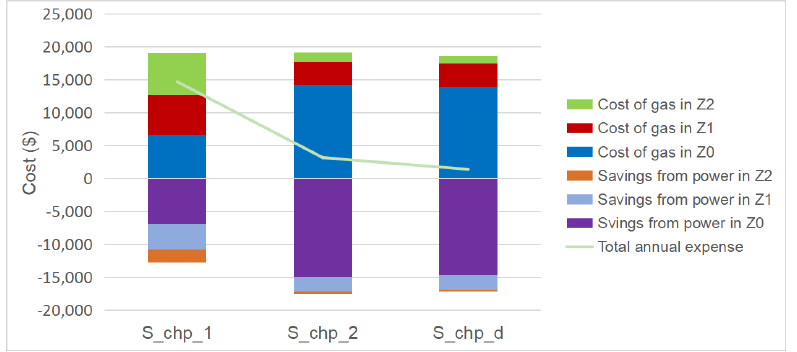
Figure 9. Annual energy cost and saving for CHP with different